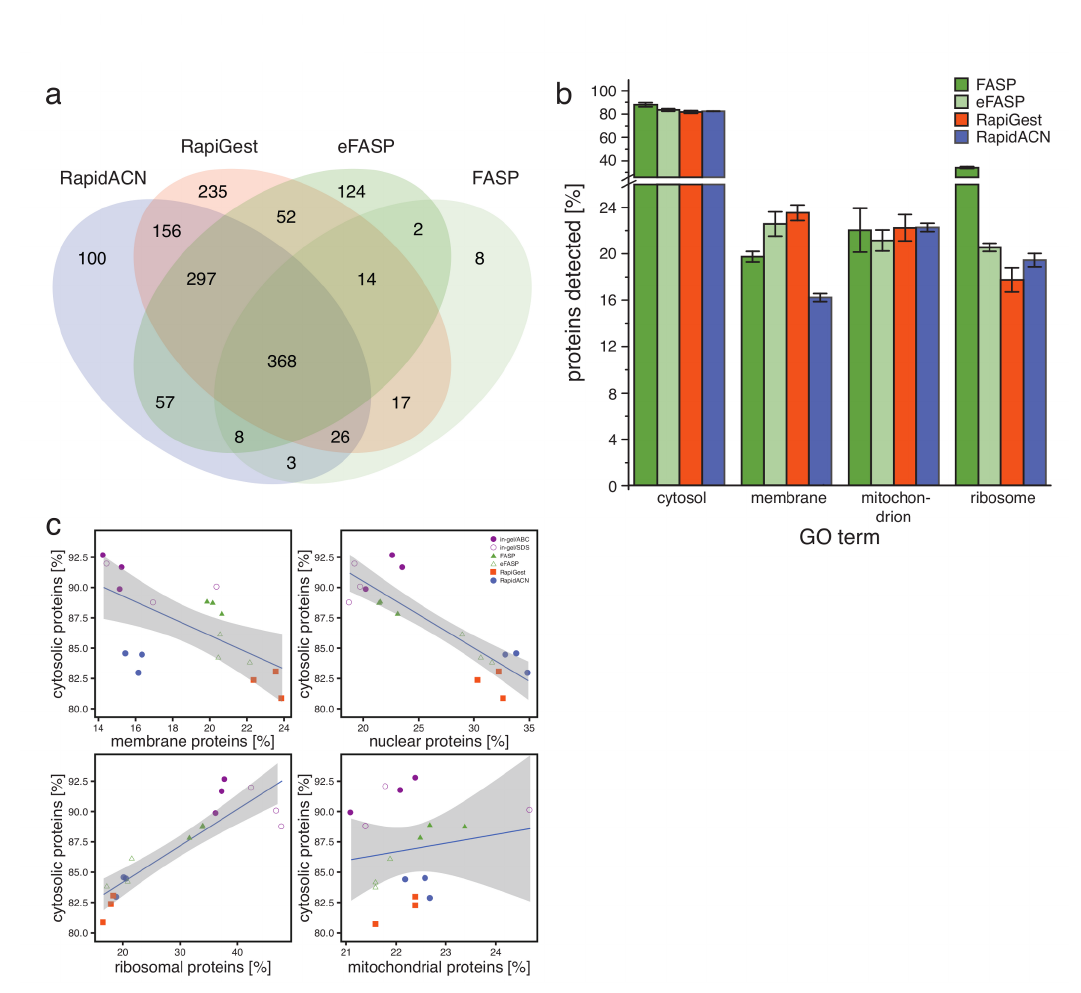
Figure 3. Protocols cover cellular compartments differently. ( a ) RapiGest and eFASP cover a unique space in the proteome. Identified proteins were visualised in a Venn diagram, excluding the in gel protocols. The RapiGest procedure yielded most unique IDs, followed by eFASP and RapidACN (n = 3). ( b ) SDS-containing protocols are best suited for the extraction of membrane proteins. For the analysis of annotated functions in each protocol, selected GO terms were expressed as percentages of identified proteins. While cytosolic proteins were not enriched in any protocol, membrane proteins were preferentially detected in the SDS-containing protocols. (n = 3, Error bars = +/- S.D.) ( c ) Filter-aided sample preparations yield a balanced representation of the proteome. The identified proteins were plotted against the percentage of proteins annotated by the GO term cytosol, in order to illustrate the similarity of extraction properties. The protocol properties required for efficient extraction of membrane and nuclear proteins is inversely correlated with the extraction efficiency for cytosolic proteins, while there is a positive correlation with ribosomal